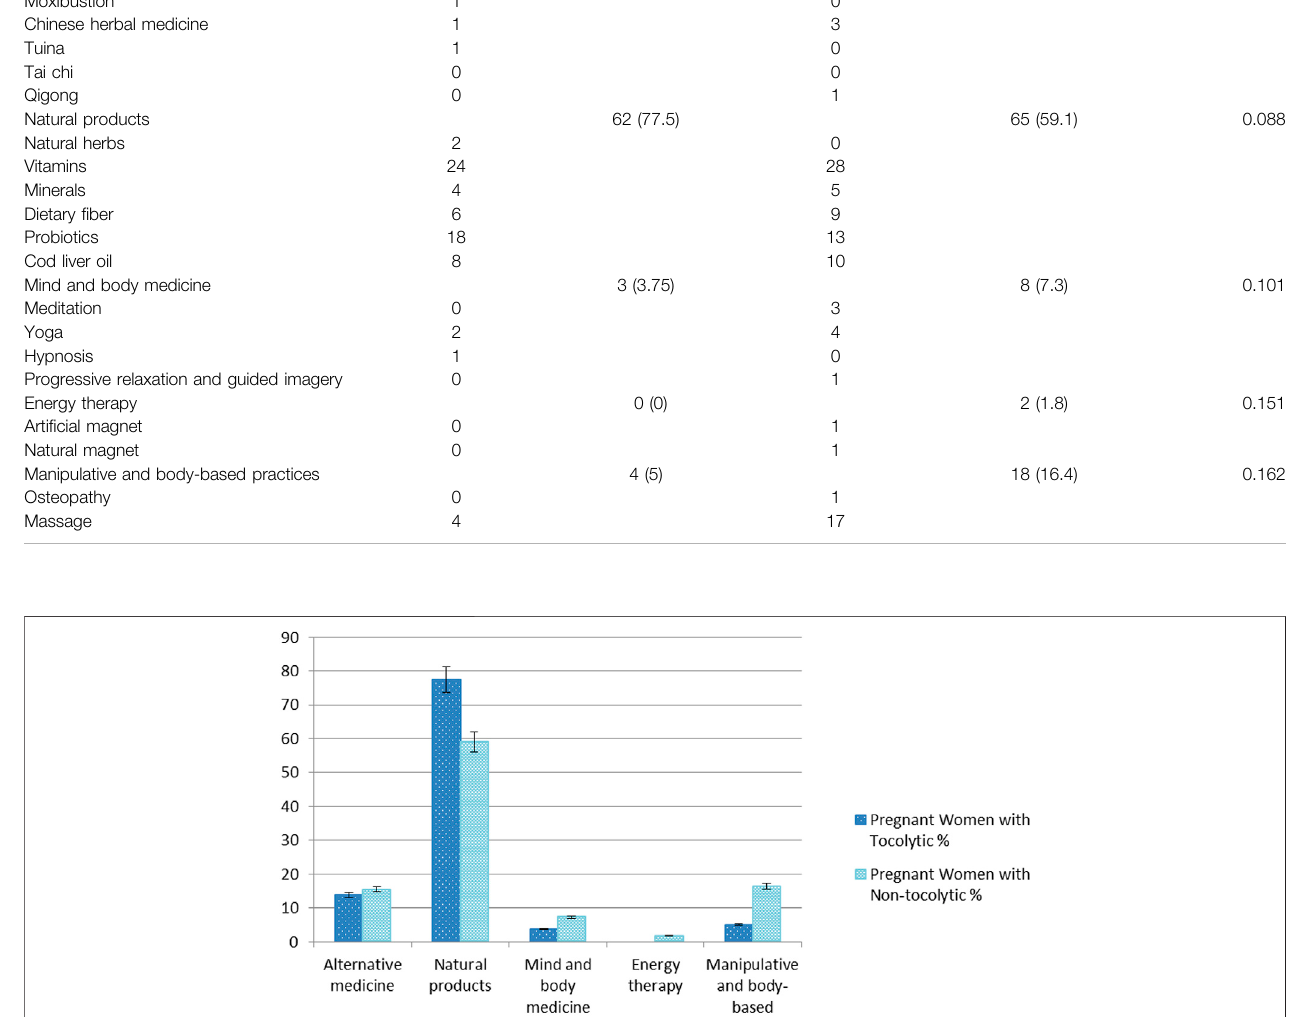
Frontiers in Pharmacology |